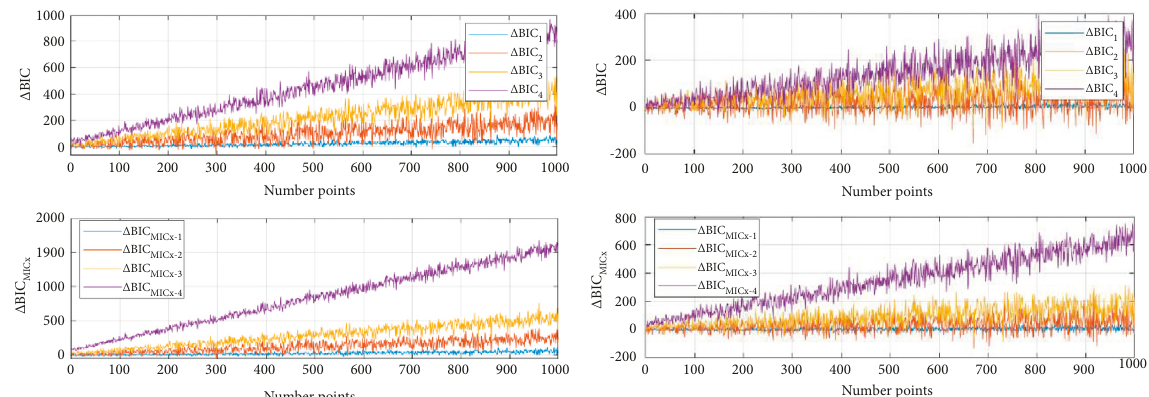
Figure 10: Top two plots: comparison of BIC and BIC MICx for the case of a power law monomial multiplied by a squashing for 15% of Gaussian noise. Bottom: comparison of BIC and BIC MICx for the case of a power law monomial multiplied by a squashing for 30% of Gaussian noise.